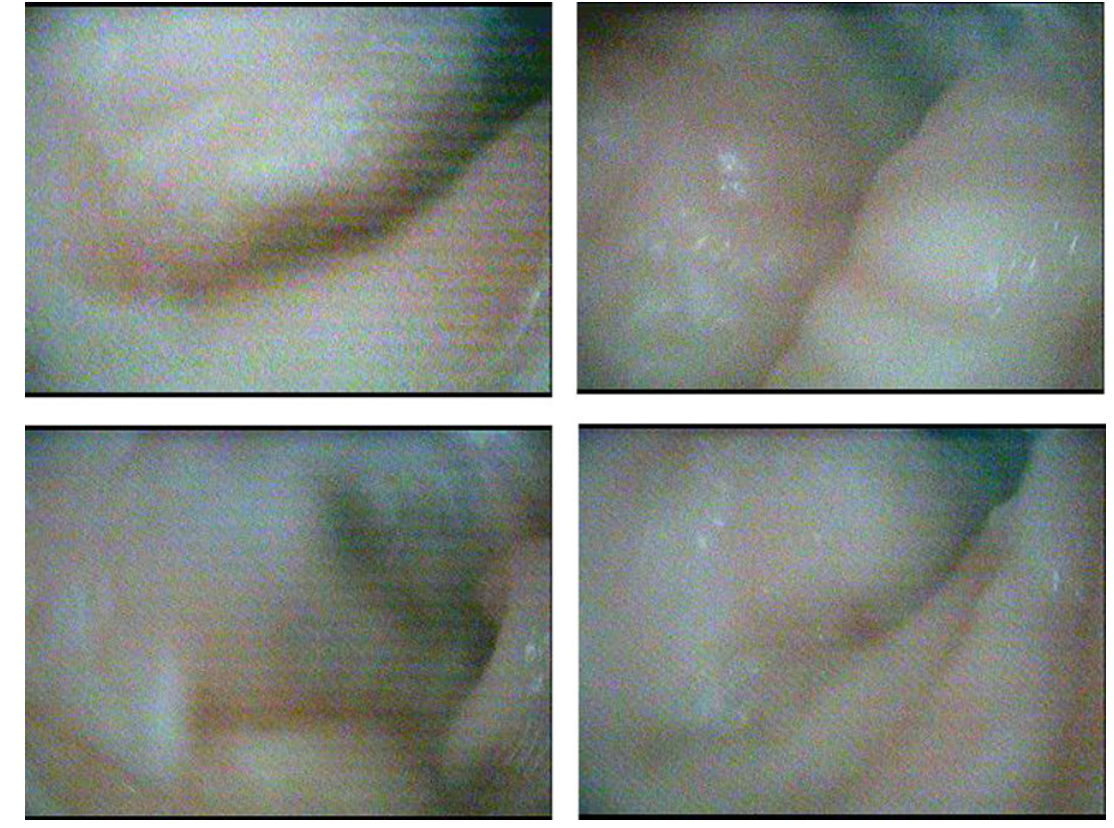
Figure 11 Snapshots of video taken by the WCE